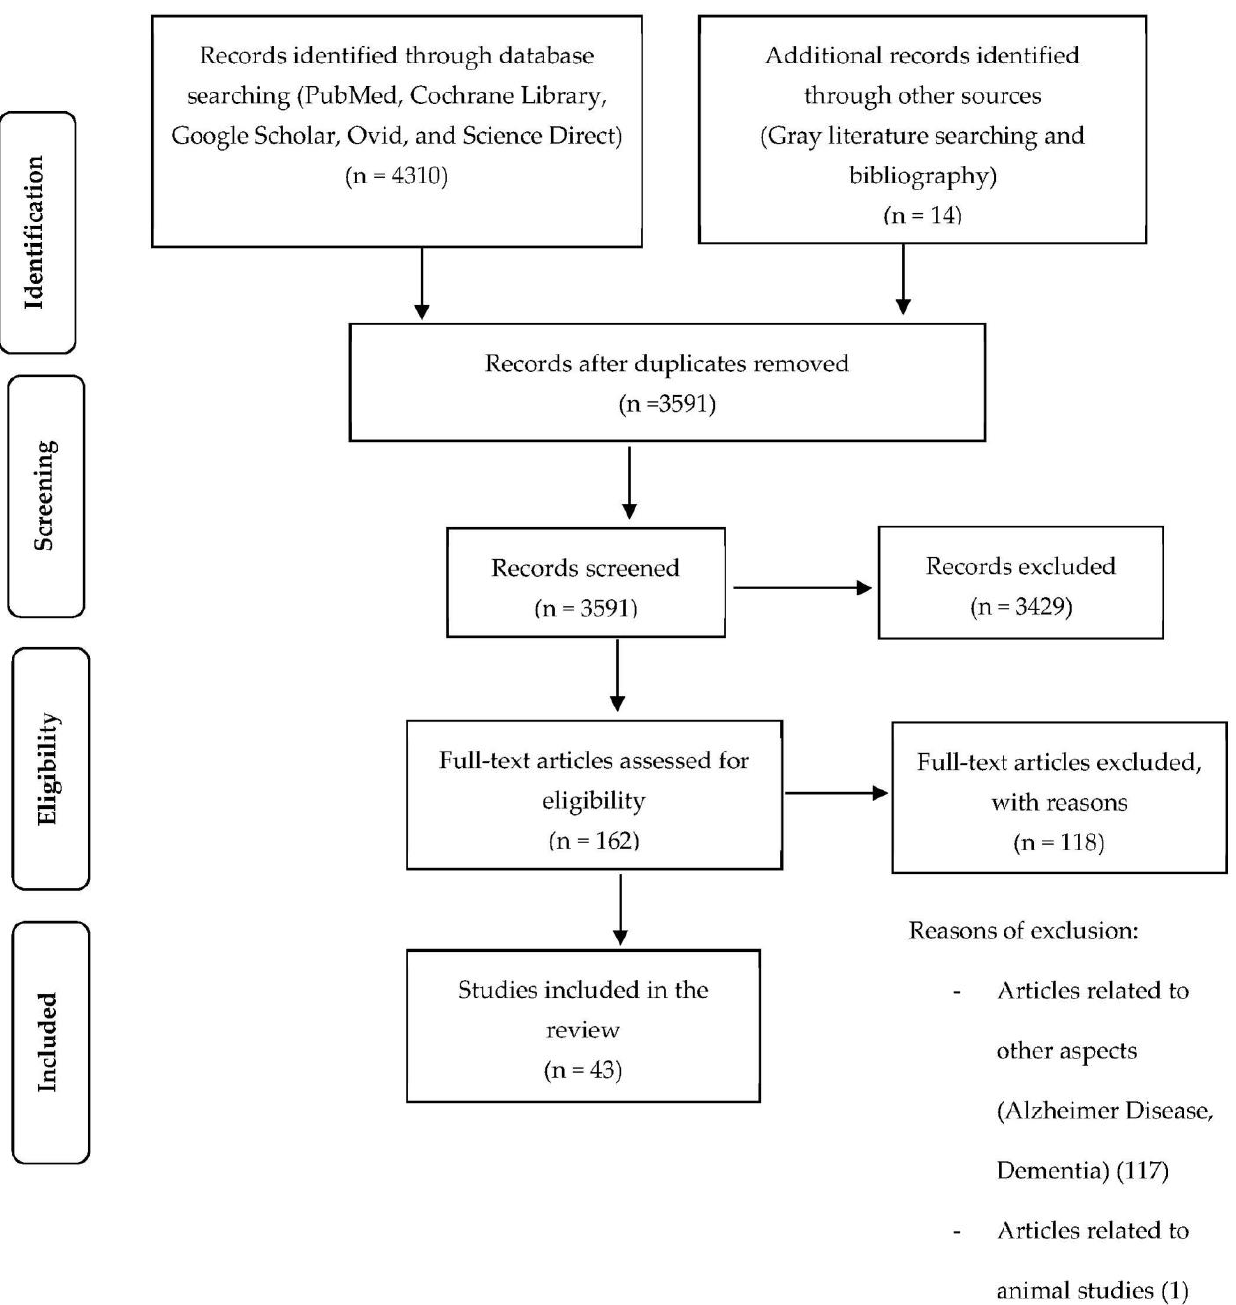
Figure 1. PRISMA flow diagram for the selection of related articles.